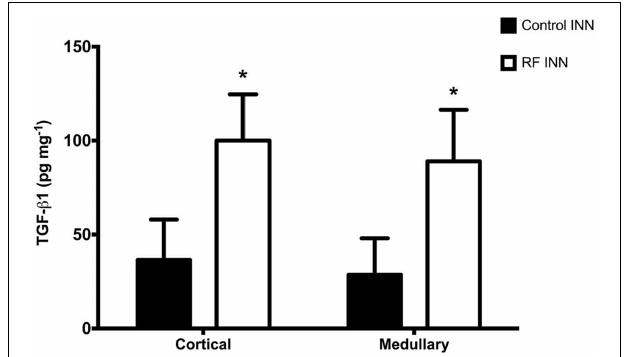
FIGURE 4 | This provides the fractional noradrenaline excretion rates (ng/mlGFR/h) for innervated control, innervated cisplatin treated (RF INN) and renally denervated renal failure (RF DNX) rats. Statistical analysis was performed using Two-Way ANOVA followed by Tukey’s post hoc test. Data presented as mean SEM. ( n = 12 for all groups). * P < 0 . 05 vs. Control INN # P < 0 . 05 vs. RF DNX. P -value for interaction < 0.0001.